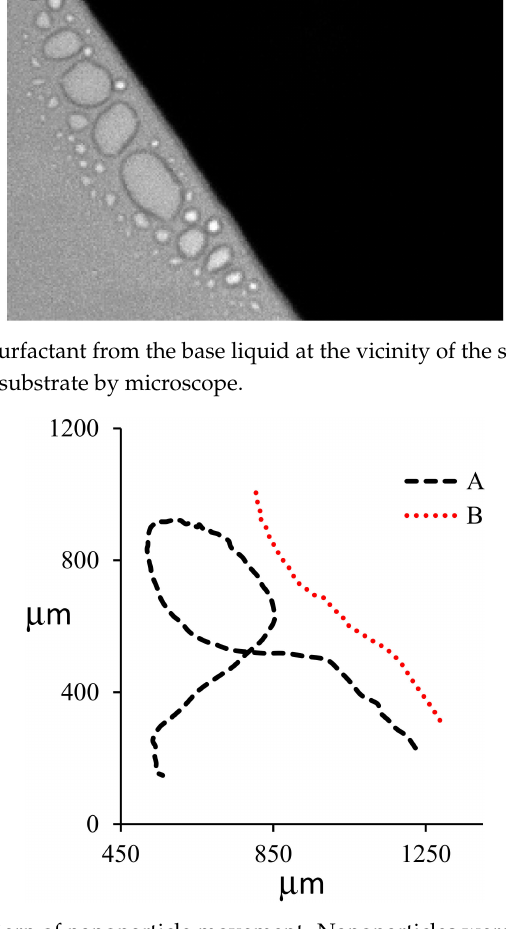
Figure 5. Typical 2D pattern of nanoparticle movement. Nanoparticles were circling ( A ) and moving outward ( B ).